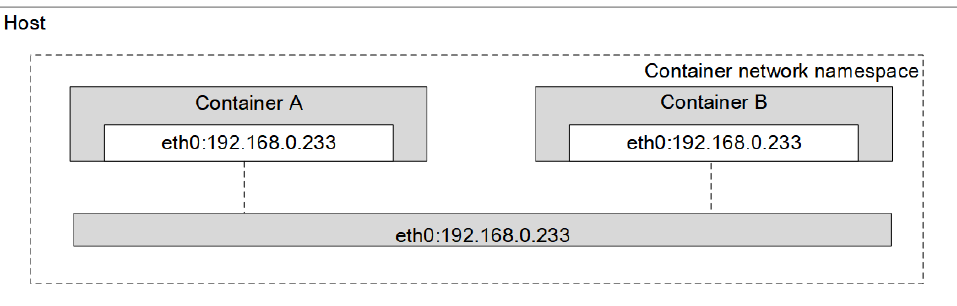
Figure 8. ‘Host Mode’ communication method in a single